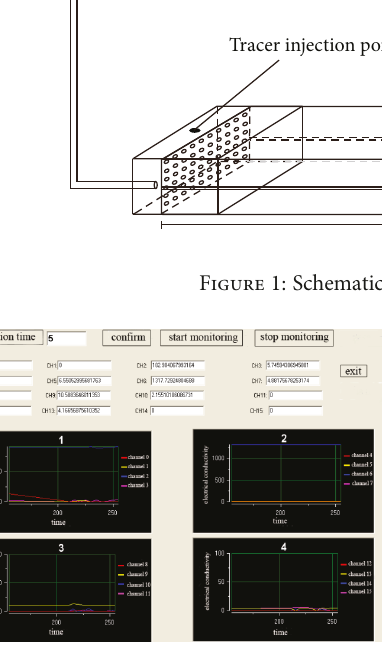
Figure 2: Data collection